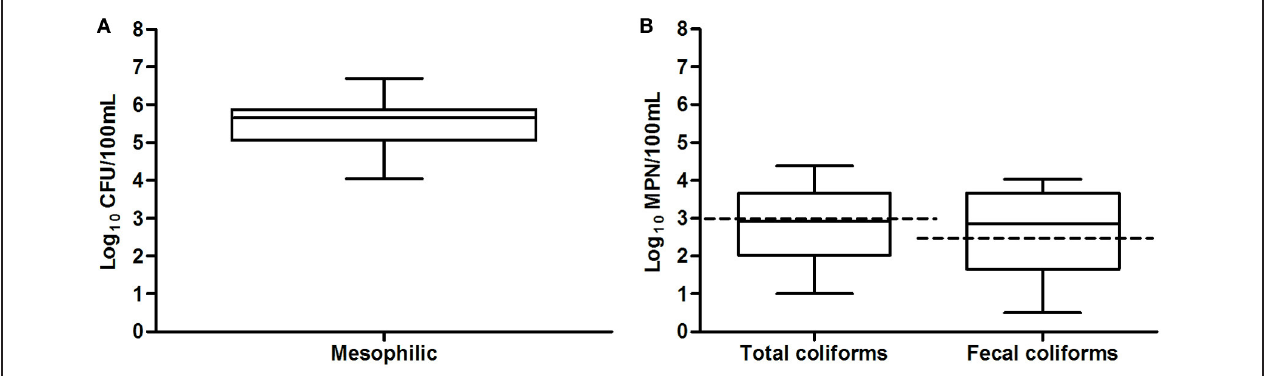
limits are shown in dotted lines. Total and fecal coliform density rating above 1000MPN/100mL and 240MPN/100mL are considered as poor